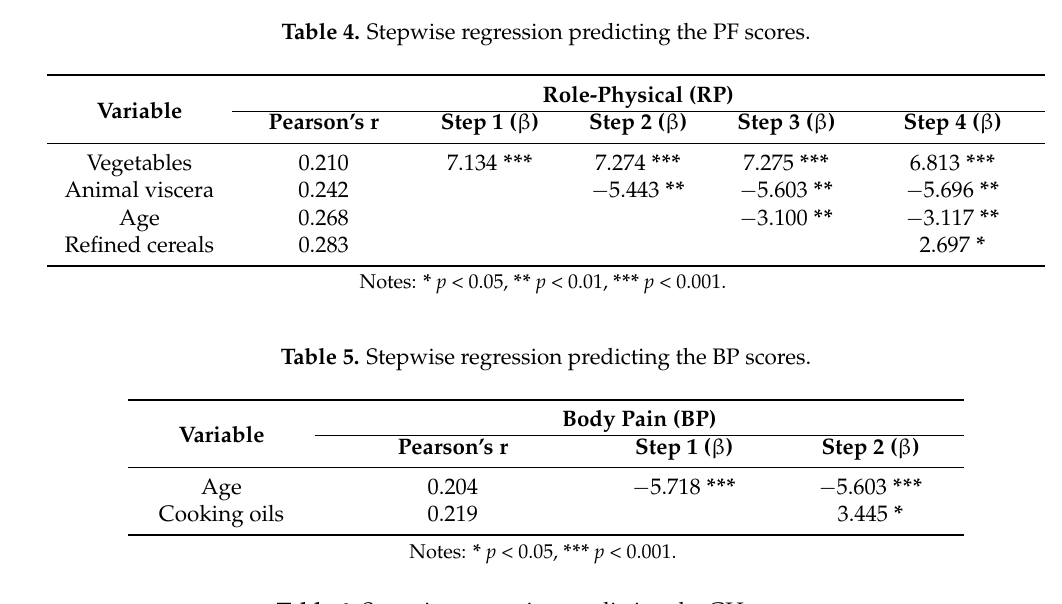
Table 6. Stepwise regression predicting the GH